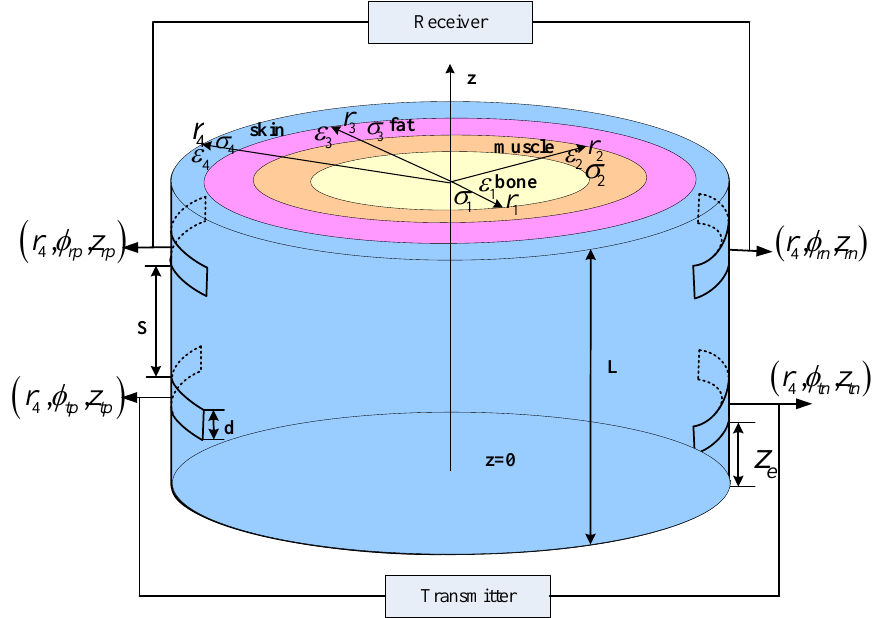
Figure 1. Illustration of galvanic-type IBC geometry on the human